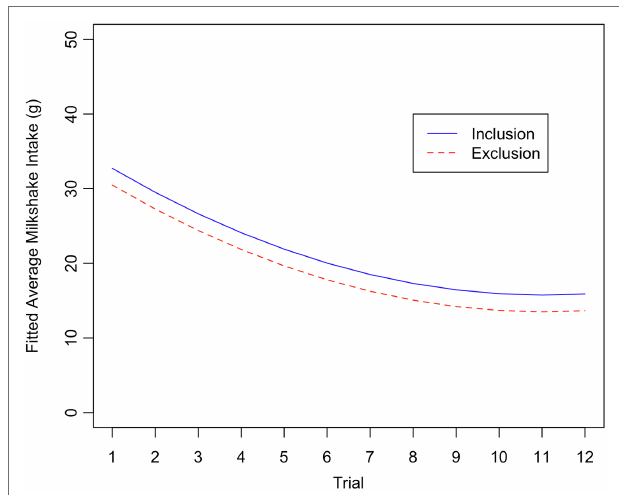
FIGURE 3 | Plot of fitted values of milkshake consumption versus trial number, by condition. Fitted values were calculated from the results of Model 1, for an average participant’s chocolate milkshake intake and for an average chocolate